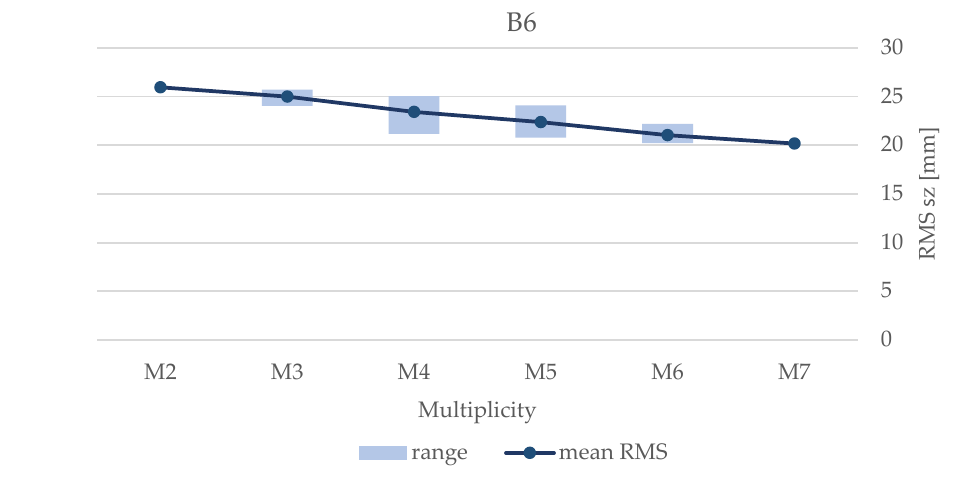
Figure 15. Graphs showing the standard deviation variability within each multiplicity grouping (minimum, average and maximum values). The data refer to Simulation 2.